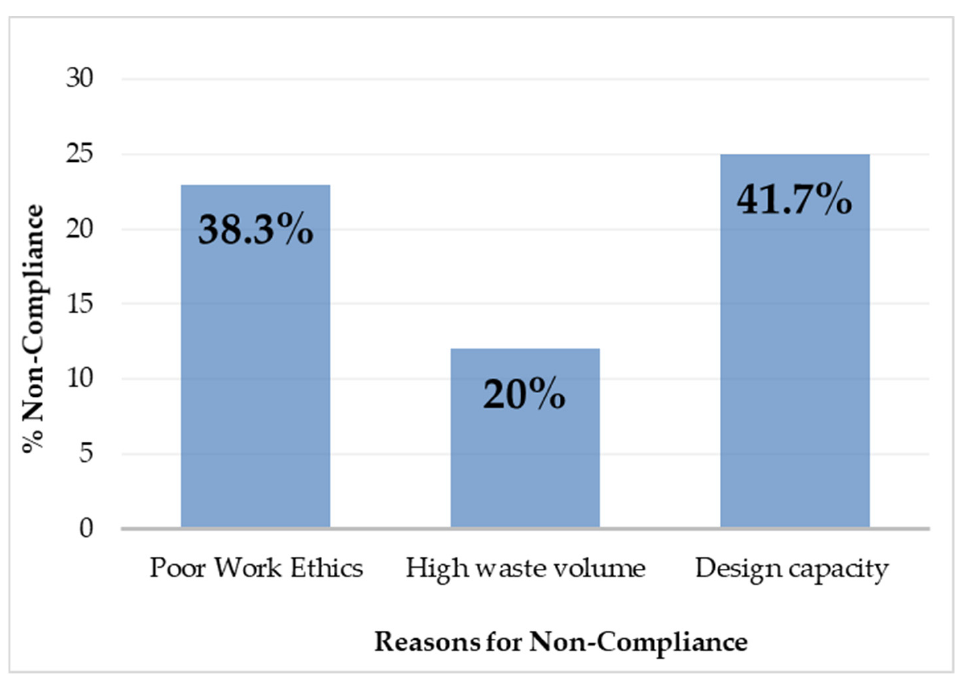
Figure 3. Reasons for non-compliance with quality standards for wastewater effluent discharge.